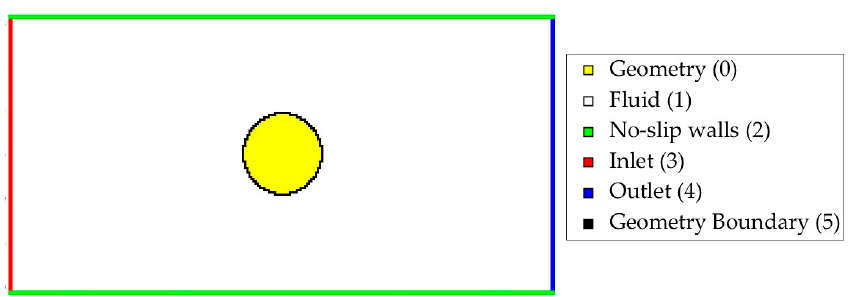
Figure 3. Flow Region Channel representation (not to scale).